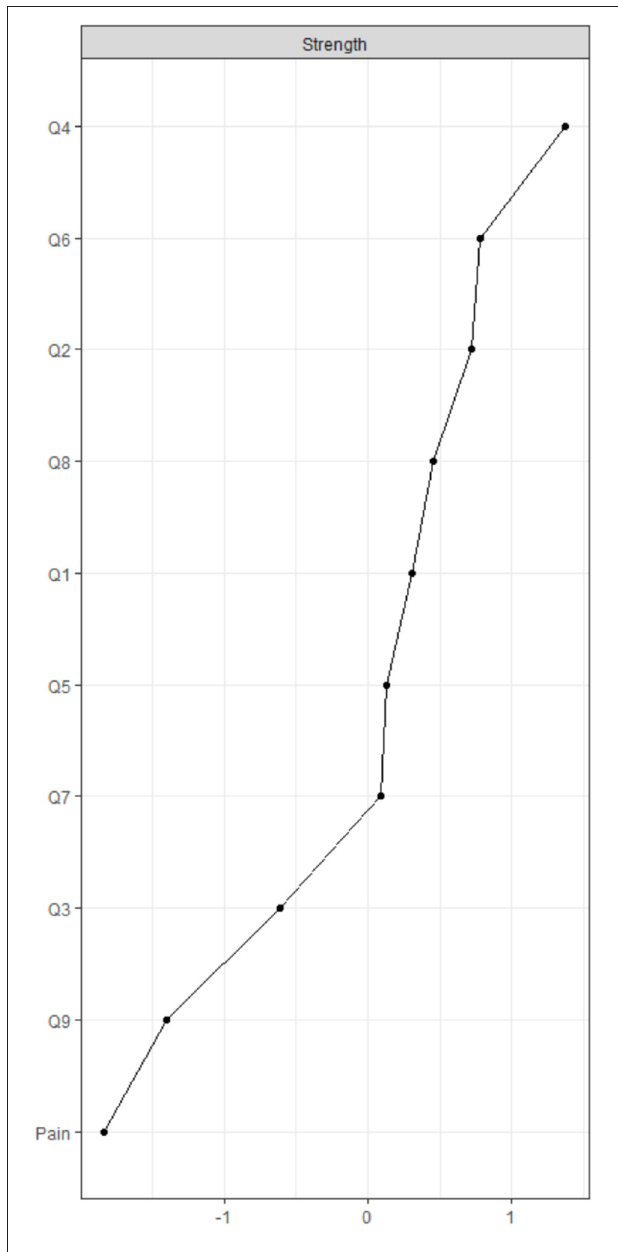
FIGURE 2 | Centrality indices of network. Q = question from the Patient Health